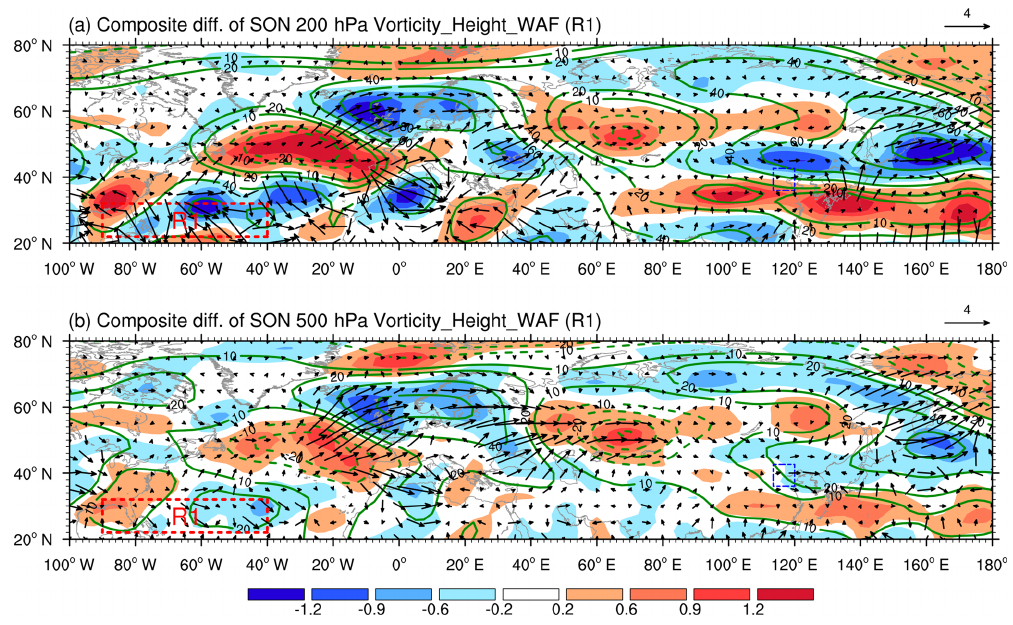
Figure 8. The autumnal composite differences of (a) 200 and (b) 500hPa WAF (vectors; m 2 s − 2 ), geopotential height (contours; gpm), and relative vorticity (shaded; 10 − 5 s − 1 ) between the three highest and three lowest years of simultaneous SST over R1 (highest minus lowest), as shown in Fig. 6. The red dashed rectangle labeled R1 is the key region where SSTAs are significantly correlated with the interannual component of the AHD BTH . The blue dashed box delineates the research domain of the BTH region.